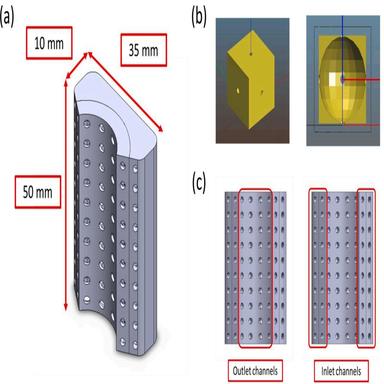
In (a) a general view of the device alongside the overall dimensions. In (b), the basic porous unit that is repeated in the 3D space to obtain the final device shape. In (c), visualization of the channels that direct diffusion to the fracture (outlet channels) and can be used to fill the device with a drug-loaded hydrogel (inlet channels).